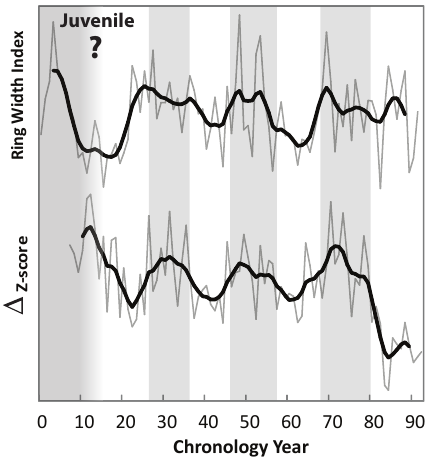
Figure 7. Correspondence of Piceoxylon tree-ring width indices (RWI) and stable isotope chronologies. (Upper) Piceoxylon RWI ( n = 92, gray line) with 7-year triangular running mean (bold black line) to highlight low-frequency variability. (Lower) Piceoxylon iso- tope (cid:49) Z-score chronology ( n = 86, gray line) with 7-year triangu- lar running mean (bold black line) to highlight low-frequency vari- ability. Here, gray boxes denote warmer and cloudier decades with above average tree ring growth. The first seven tree rings of the RWI record were not analyzed for stable isotopes, due to concerns about possible influences of juvenile tree growth on the isotope record. Question mark at the beginning of the TR record depicts uncertainty due to a possible juvenile growth signal.